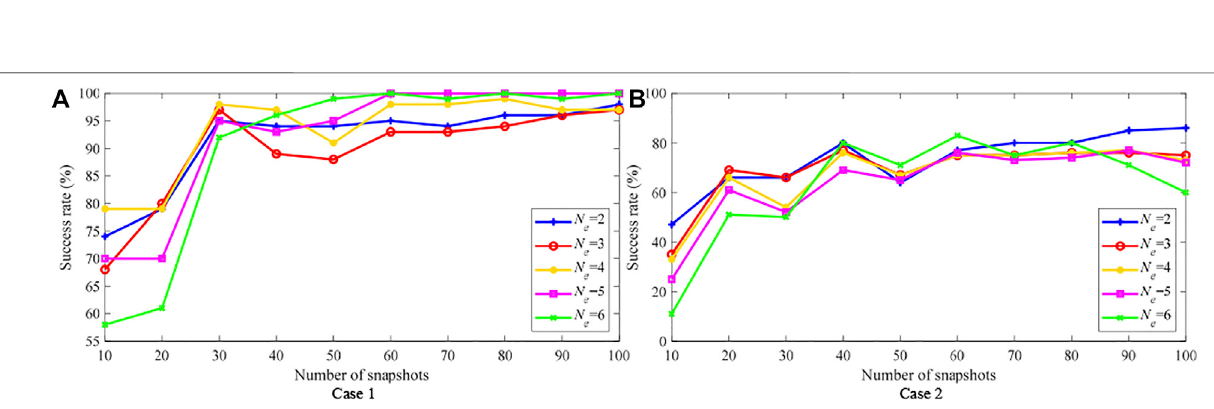
FIGURE 5 | PEI success rate of the IEEE 30-bus system.